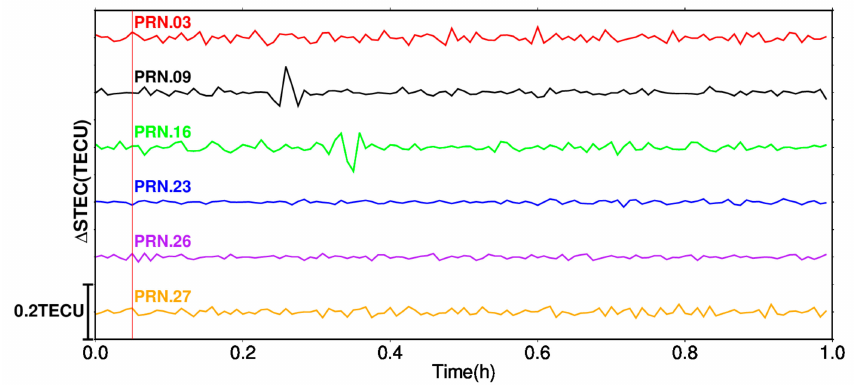
Figure 13. The ∆ STEC time series of SCYY tracking station and GPS satellites over the station, in which the vertical red line on the left represents the occurrence of